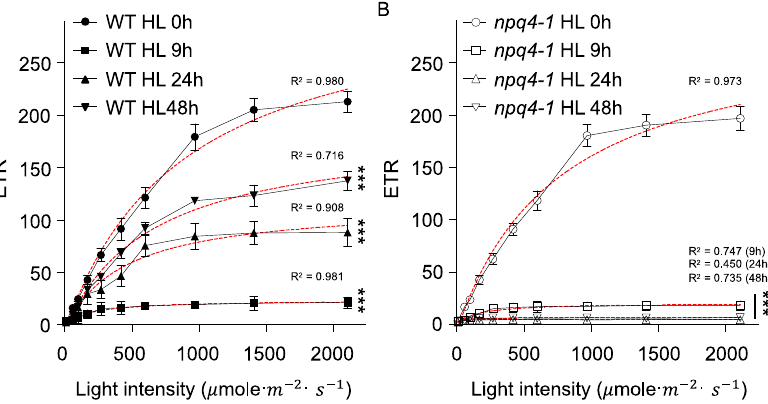
Figure 4. Light response curves for electron transport rate in wild-type and npq4-1 mutants during high light illumination. Leaves of 4-weeks-old seedlings grown in a growth chamber were treated with high light (HL) at 700 μ mol photons m − 2 s − 1 for 0, 9, 24, or 48 h and dark-adapted for 10 min before the measurement of electron transport rate. Each photosynthetically active irradiance of 0, 70, 110, 180, 250, 400, 550, 900, 1400, or 2200 μ mol photons m − 2 s − 1 was applied for 10 min for the measurement in ( A ) WT; and ( B ) npq4-1 mutant leaves. The electron transport rate was calculated as described in Section 4. Each point represents the mean of at least four experiments (SD indicated by the bar). Regression line plotted as red dashed line estimated via nonlinear least square regression. R 2 denotes the regression coefficient. Significance differences of fitted curves are indicated by asterisks (*** p < 0.001) compared to the 0 h as determined by one-way ANOVA with Fisher’s LSD test.